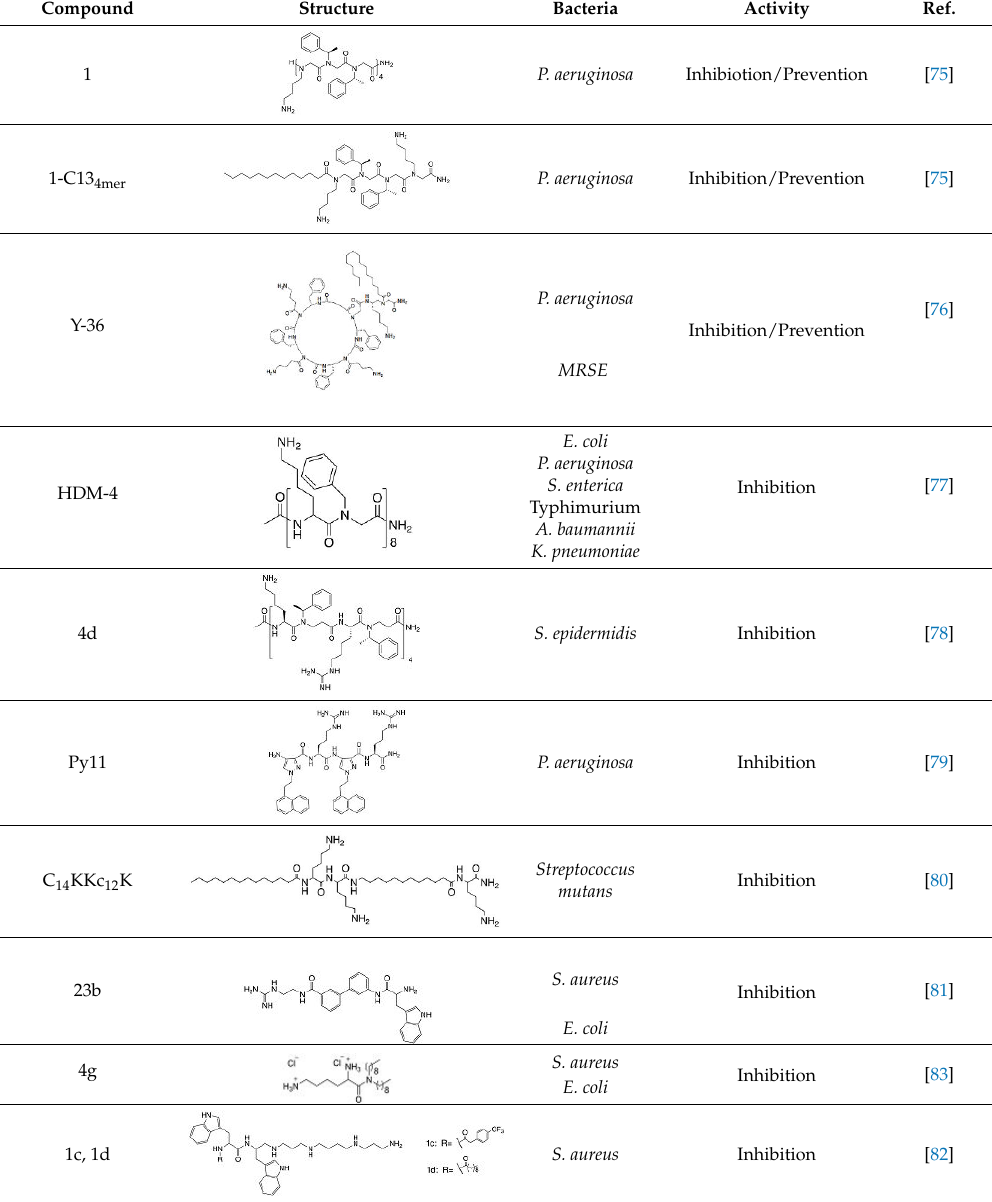
Table 3. Examples of peptidomimetics with antibiofilm